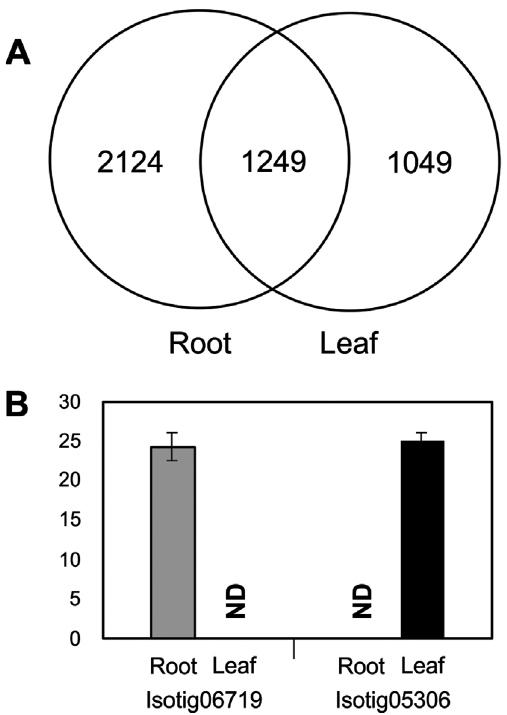
Figure 4 - Root or leaf specific candidate genes identified in response to droughtstressinthewheatcultivarMGS1Aliança.(A)Venndiagramrep- resenting the number of candidate genes obtained after DEGseq analysis. The candidate genes are distributed in root and leaf according to CAP3 as- sembly. (B) RT-qPCR analysis of two randomly selected specific tran- scripts, showing that isotig06719 (see primer sequences on Table S2) is specifically expressed in root tissue and the isotig05306 (primers CCGTGTCACTTCCCTTGATT and GGAGAGGTTGAGATGGGT GA) is expressed in leaves only. “ND” means not